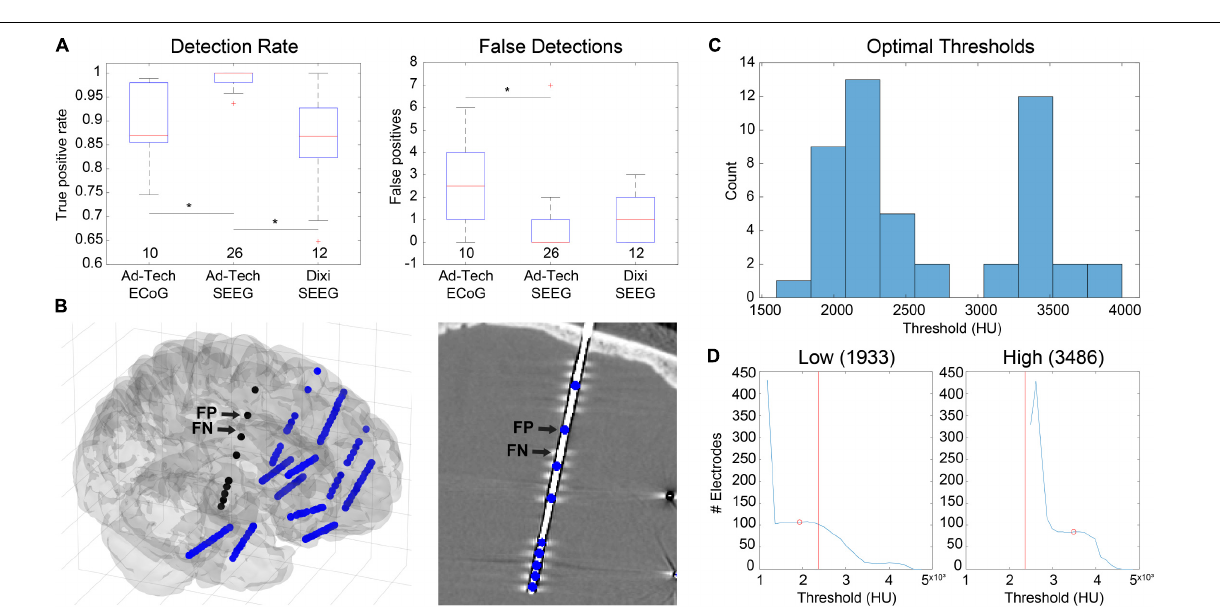
( Figure 3C ). When grouped by electrode type, no significant difference in threshold was found [Kruskal-Wallis (KW) test, df = 2, χ 2 = 2.47, p = 0.29], indicating that the bimodality of optimal thresholds could not be attributed to the type of electrode implanted. These results indicate the potential benefit of using multiple thresholds when detecting electrodes across different datasets. Examples are given for two datasets that have a low ( Figure 3D , left) and a high ( Figure 3D , right) optimal threshold, respectively. The number of detected electrodes as a function of threshold are shown for each dataset. The median optimal